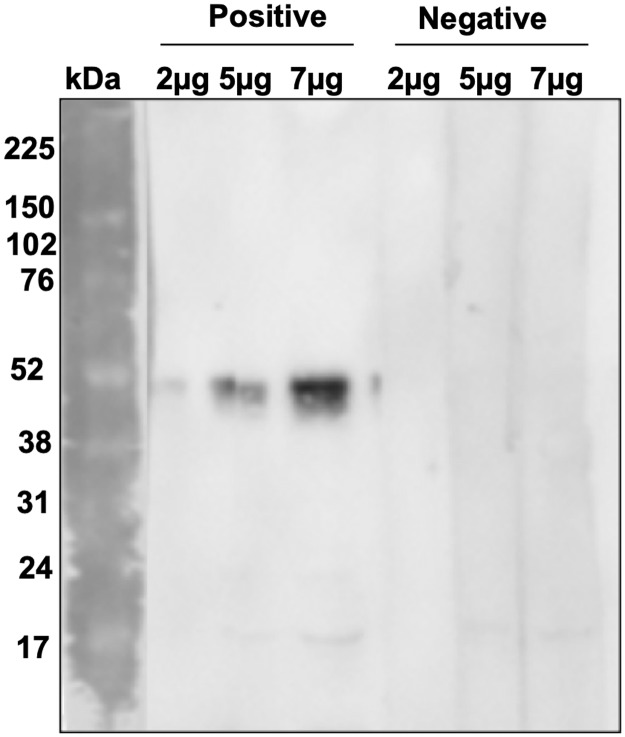
Western blotting anti-rMEA using sera from positive and negative individuals for S. mansoni infection.A PVDF membrane was coated with three different concentrations of rMEA (2, 5 and 7 μg). The lanes were probed with positive (Group 1) and negative (Group 5) pooled sera at 1:800 dilution. The peroxidase conjugated anti-human IgG antibody was added at 1:80,000. Group 1: S. mansoni chronic sera; Group 5: negative sera from health donors.